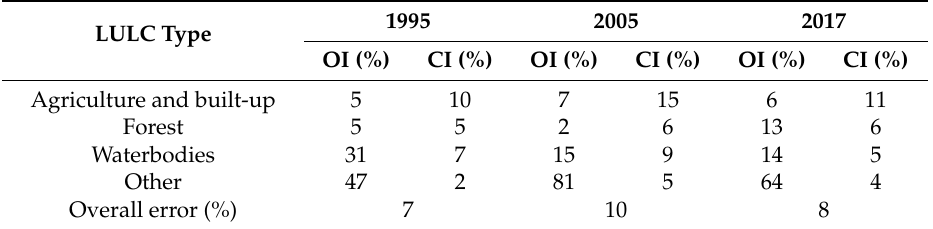
Table 5. Summary of Landsat classification errors for classified maps of 1995, 2005 and 2017.